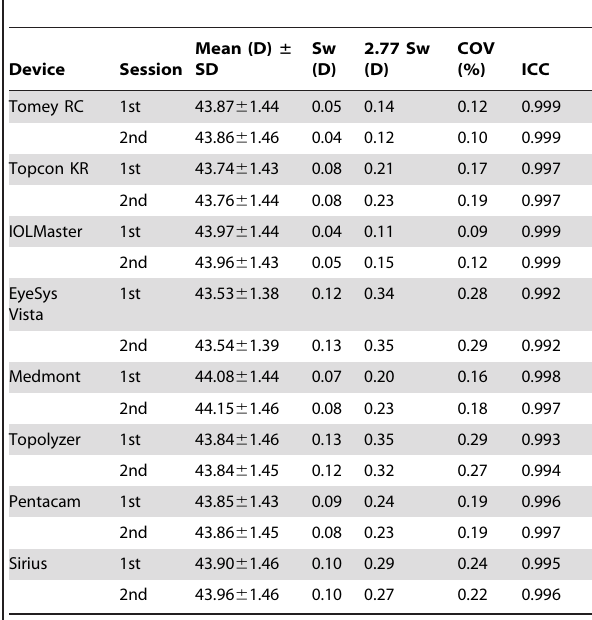
Table 1. Intrasession Repeatability of 8 Different Devices in Measuring Flat Keratometry (N =35).